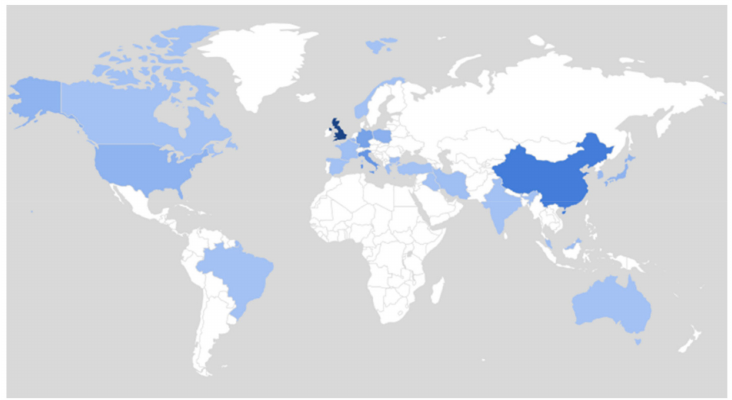
Figure 8. World map of the publications distributed for each country.